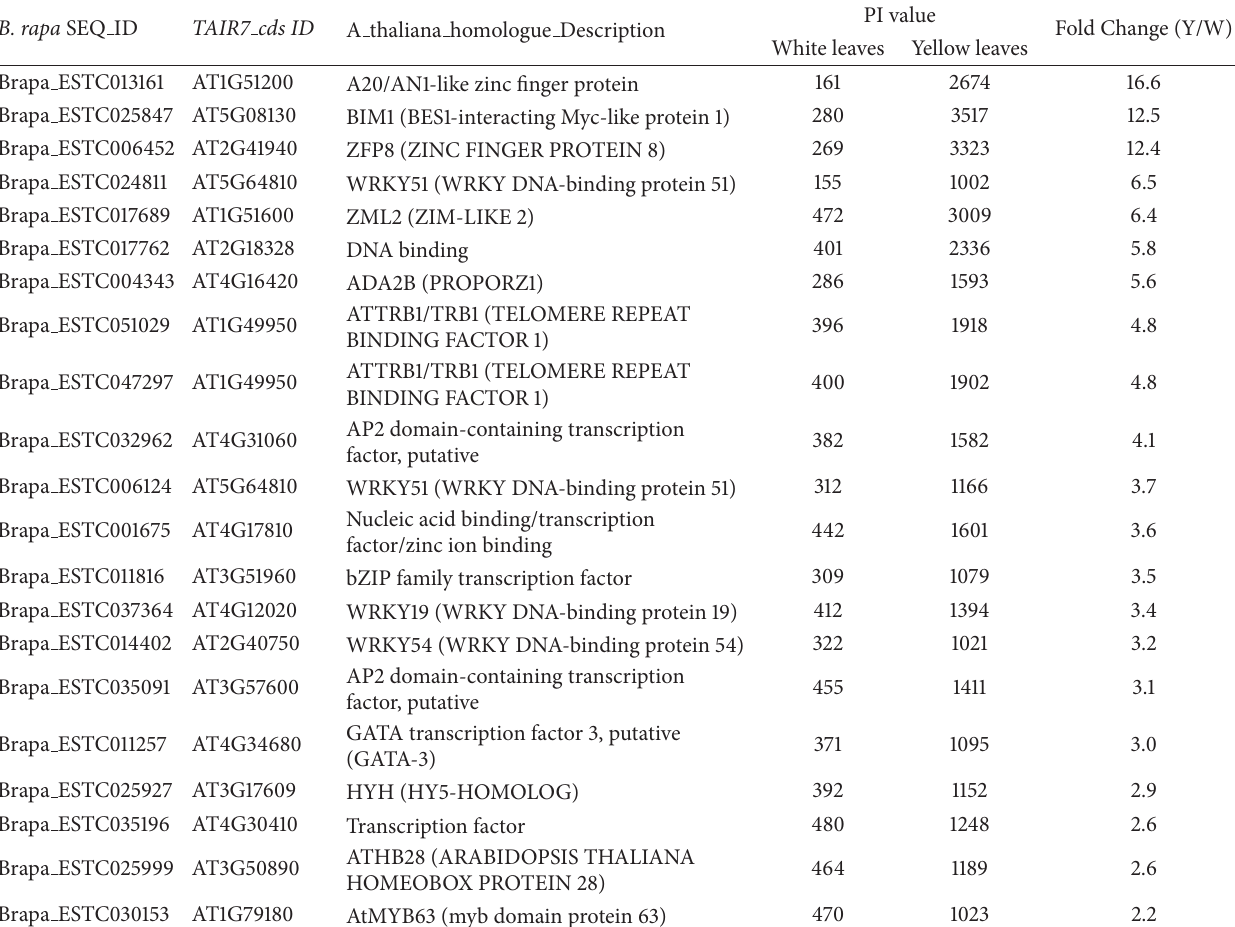
Table 4: List of transcription factors expressed specifically in yellow inner